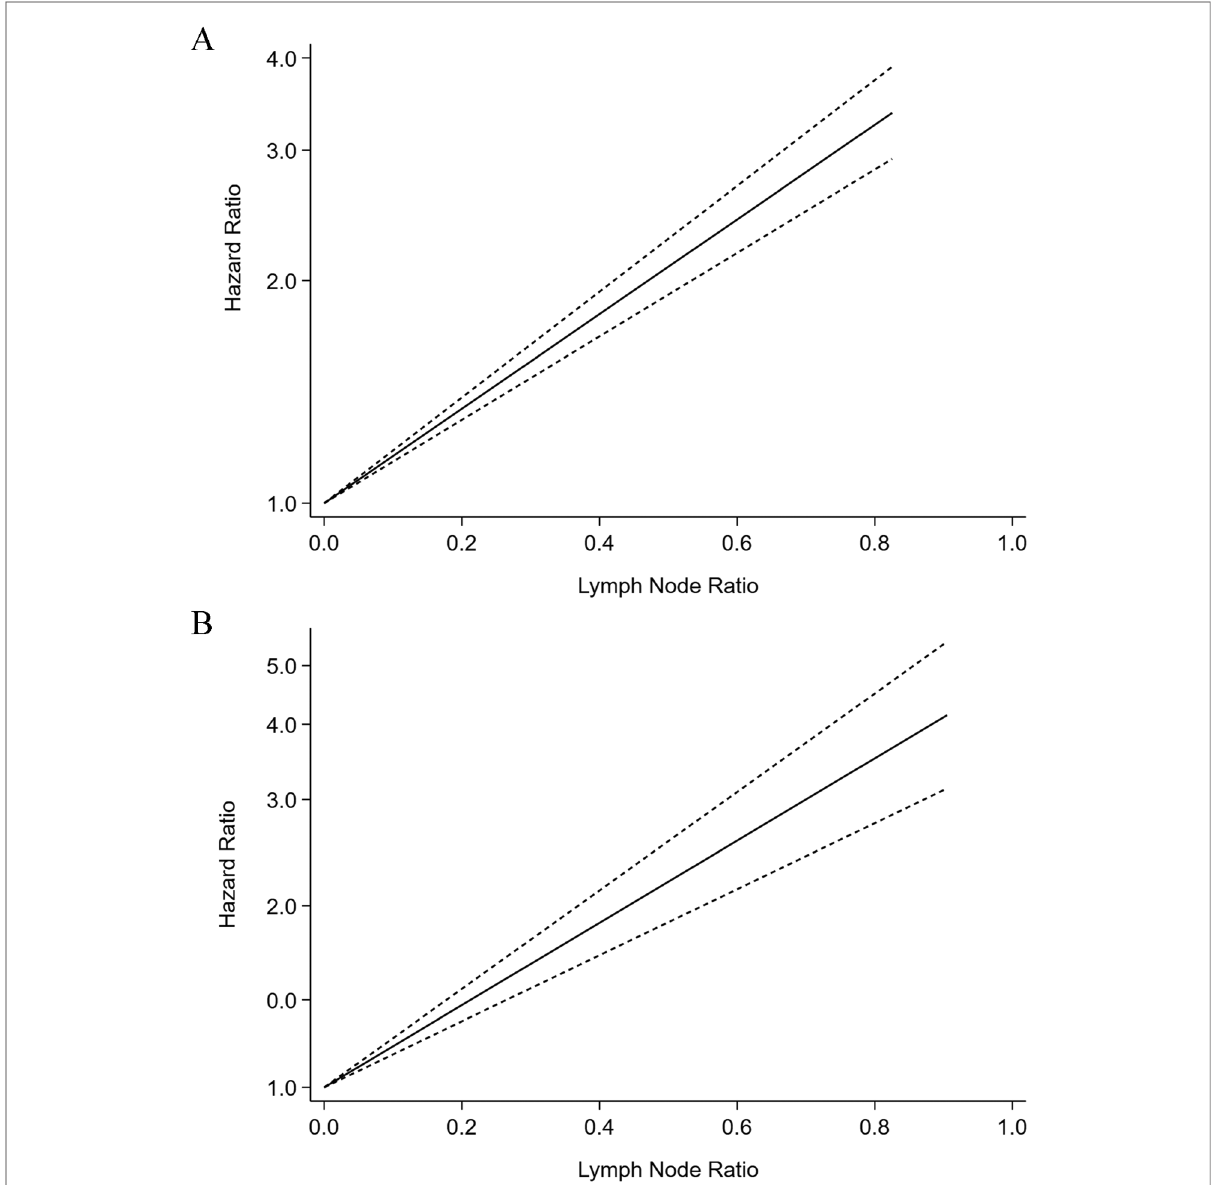
FIGURE 4 Dose-response meta-analysis of the prognostic role of lymph node ratio in overall survival (A) and disease-free survival (B) of the breast cancer patients after neoadjuvant